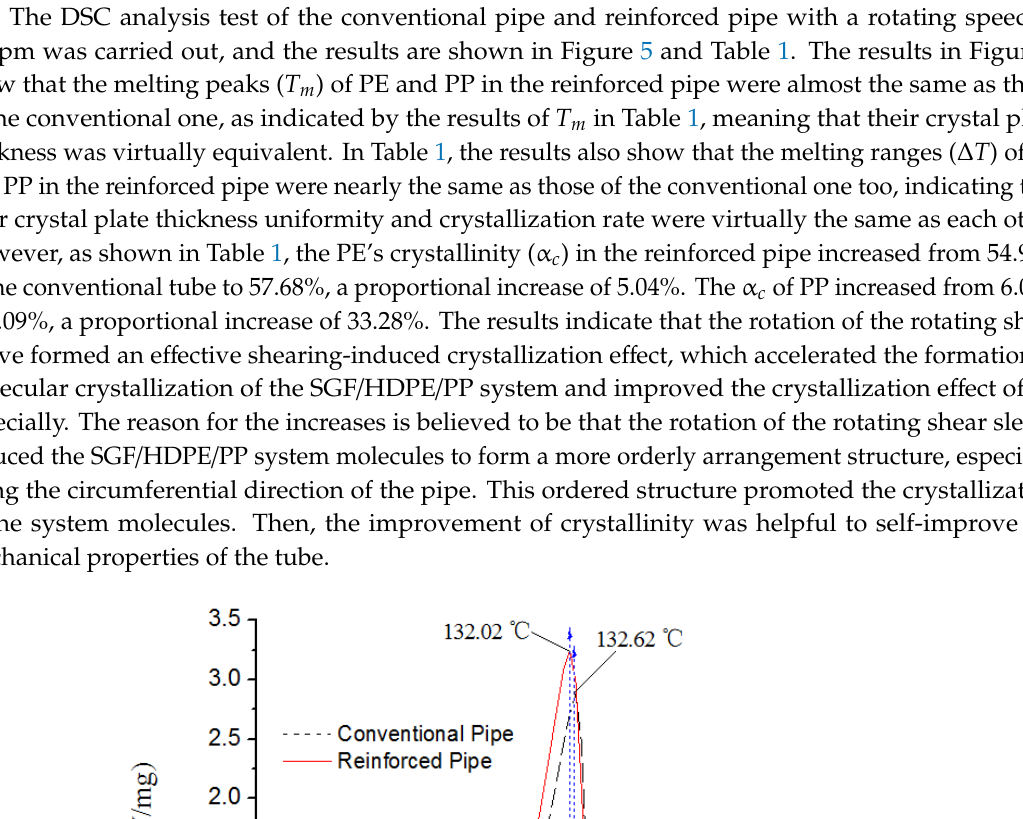
Table 1. The second heating DSC testing results of the SGF/HDPE/PP pipe.